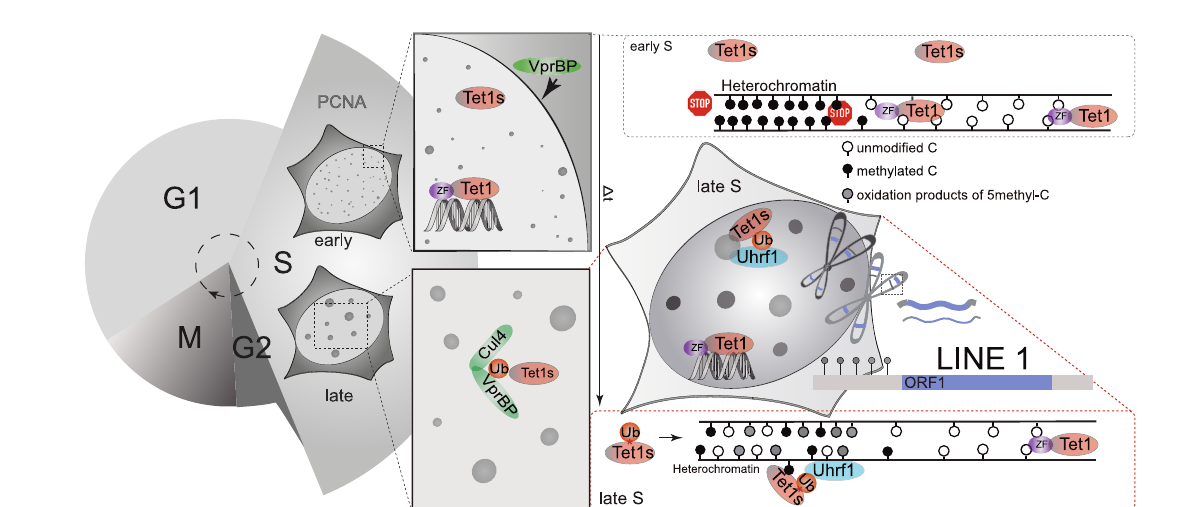
Fig.10|ModelofTet1sandTet1regulationduringthecellcycle. Tet1viaitszinc fi nger domain is tethered away from heterochromatin, which prevents